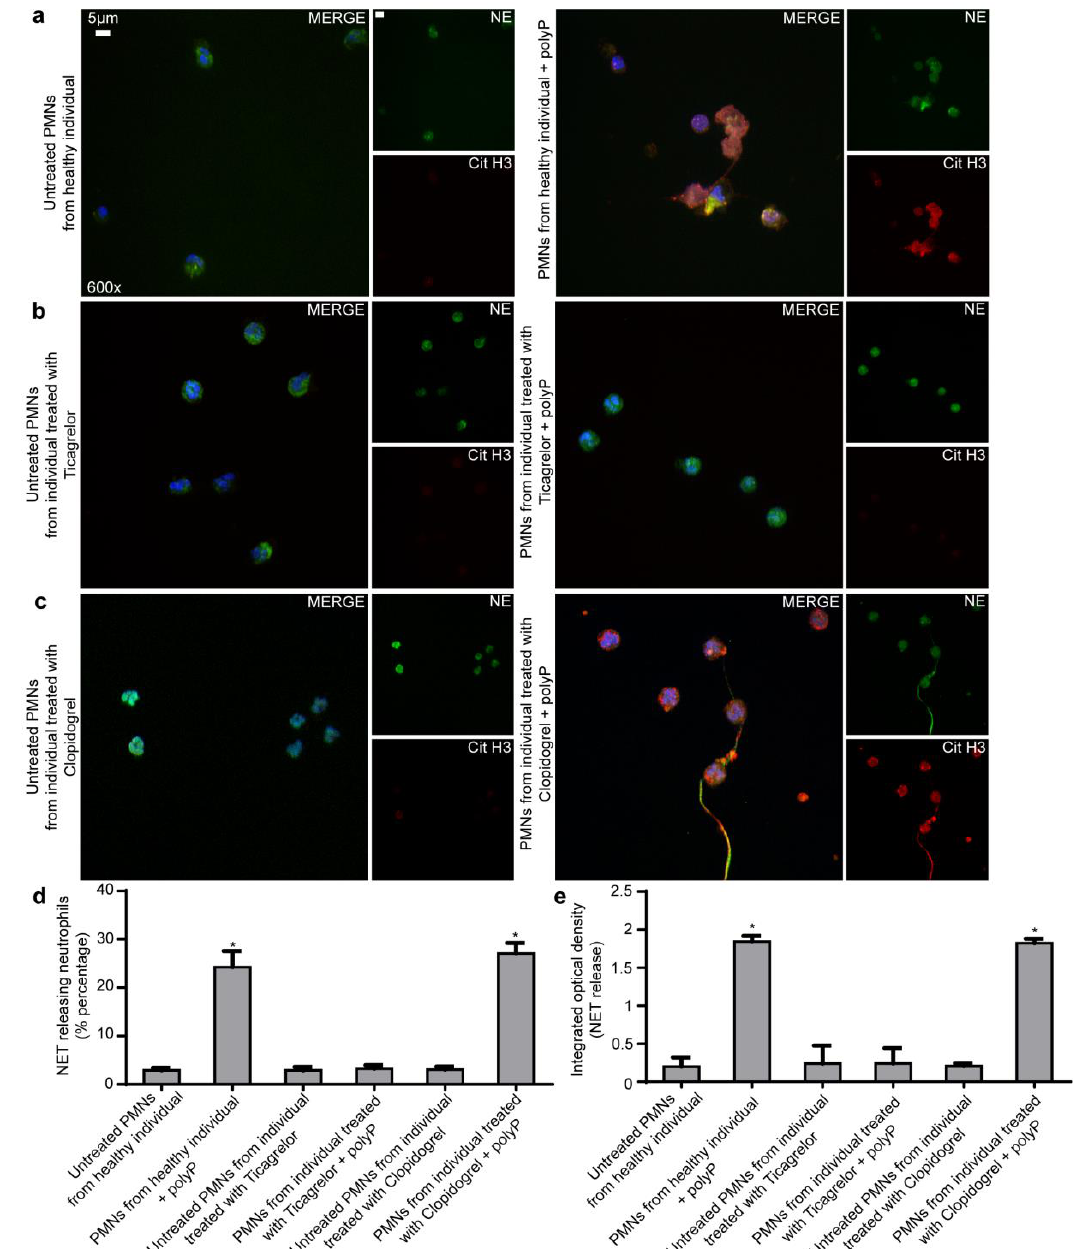
Figure 2. Neutrophils from individuals receiving Ticagrelor were more resistant to NETotic stimulation from polyP. ( a – c ). Fluorescence microscopy for cit-H3 / NE staining in neutrophils isolated from a patient with a previous acute coronary syndrome and stent placement that receives Ticagrelor or Clopidogrel as a main antiplatelet treatment and neutrophils from a healthy individual, with or without synthetic polyP. One representative out of five independent experiments is shown. Original magnification: 600 × , Scale bar: 5 µ m. Blue: DAPI, Green: NE, Red: cit-H3. ( d ). Percentage of NET-releasing neutrophils as assessed by immunofluorescence. ( e ). MPO-DNA complex levels in NET structures from these stimulations, as assessed by ELISA. Data from five independent experiments presented as mean ±